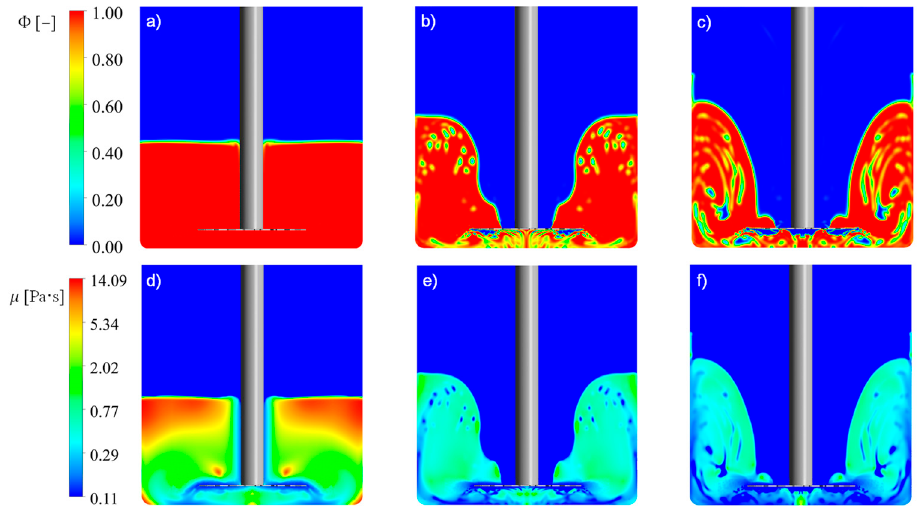
Figure 3. Volume fraction Φ profiles for case 3 for rotational speeds of ( a ) 500, ( b ) 1200, and ( c ) 3000 rpm; apparent viscosity 𝜇 profiles (in logarithmic scale) for case 3 for rotational speeds ( d ) 500, ( e ) 1200, and ( f ) 3000 rpm.